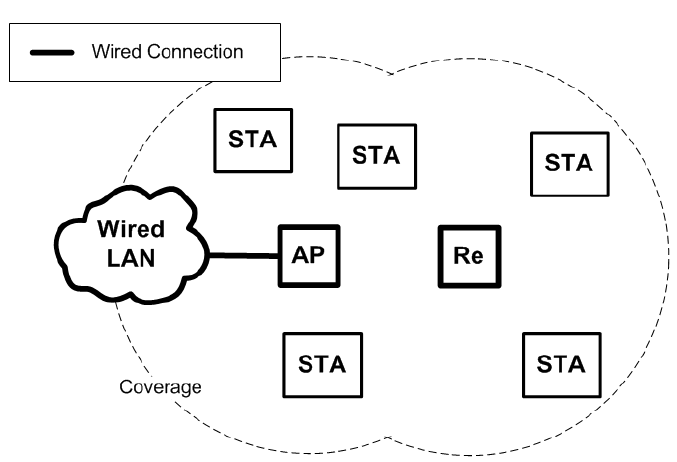
Figure 2. WLAN extended with a wireless repeater.